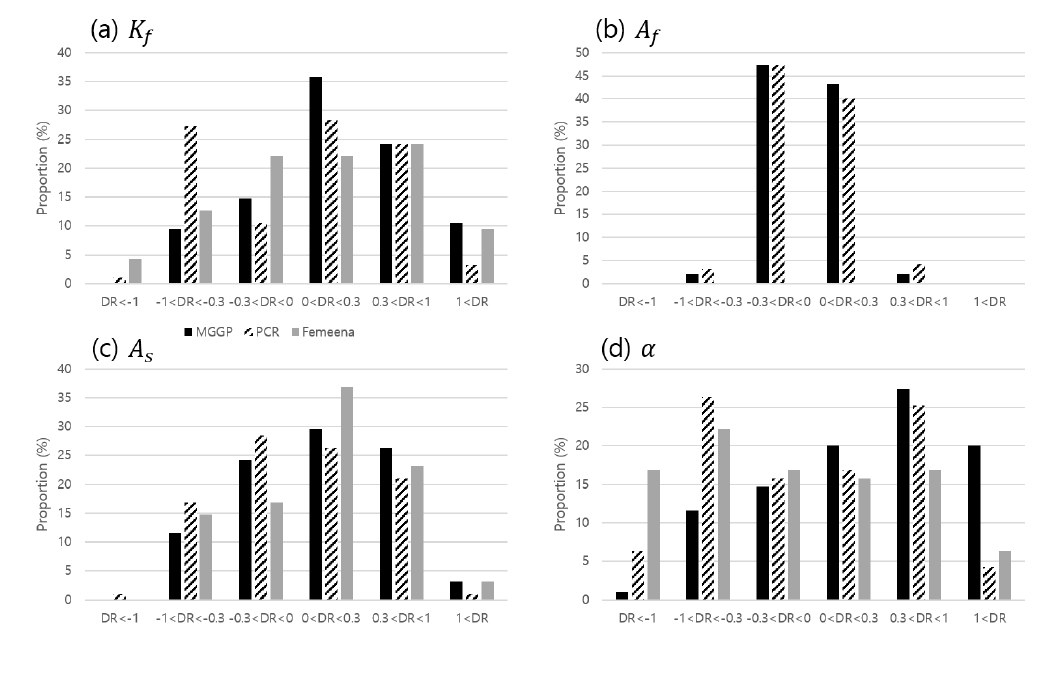
Figure 11. DR histograms of each empirical equations for TSM parameters for the training set; ( a ) K f . ( b ) A f . ( c ) A s . ( d ) α